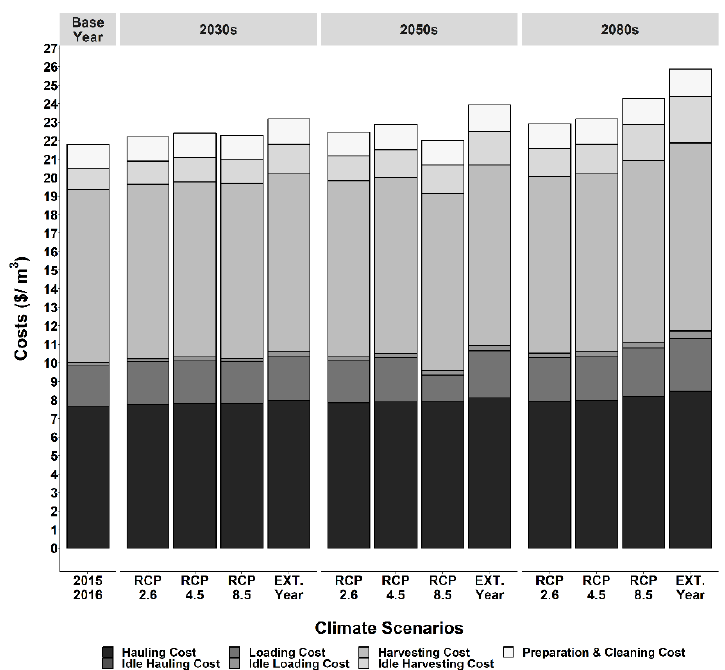
Figure 5. Total costs of logging operations (winter plus summer) where the harvested wood is hauled to both the mill and satellite yards under the current and several future intervals. The extreme year (EXT. Year) has the warmest winter in any of the RCP values of a time intervals. The normal Sundays and holidays were not available for operations. Note that there was almost no idle hauling cost in this analysis except RCP 8.5 and the extreme warm year of the 2080s.